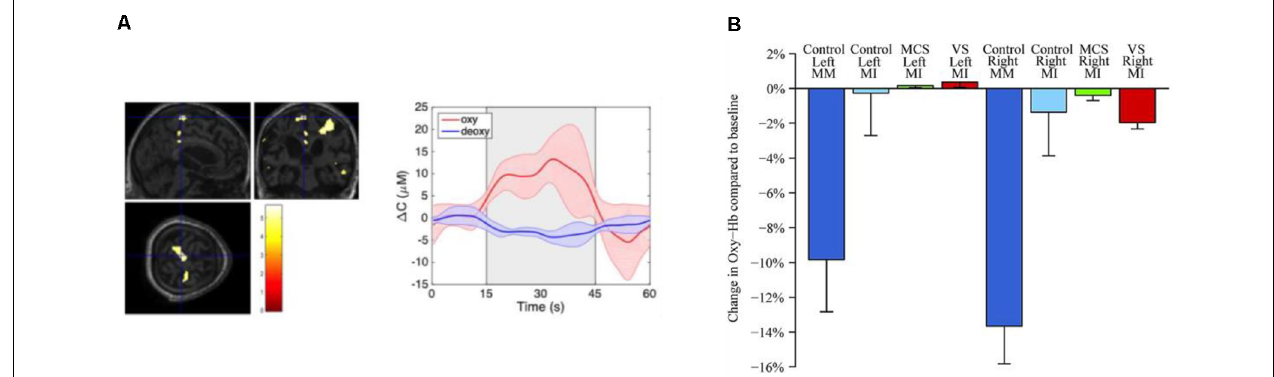
FIGURE 3 | (A) Functional magnetic resonance imaging (fMRI) and functional near-infrared spectroscopy (fNIRS) response from a VS patient during motor imagery (retrieved from Abdalmalak et al., 2020a). fMRI (left panel) depicts increased blood oxygenation level-dependent signal in SMA which is congruent with findings from fNIRS testing (middle panel) depicting an increased concentration of oxygenated haemoglobin during motor imagery block (grey shaded area). (B) Change in concentration of oxyhaemoglobin during various tasks and for VS, minimally conscious state (MCS) and healthy controls (retrieved from Kempny et al., 2016).